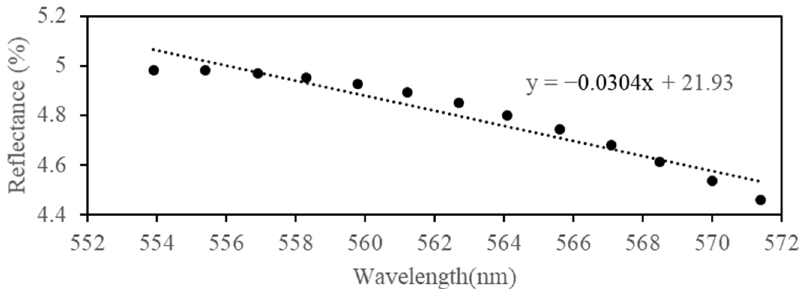
Figure 2. Figure 2. The straight line obtained by linear fitting the reflectance value and the corresponding wavelengths.